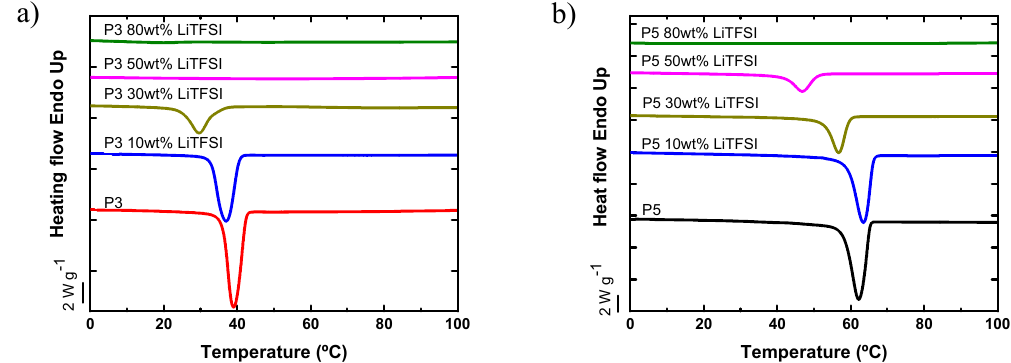
Figure 3. DSC cooling scans of neat P3 and P5 polyethers and their mixtures with different LiTFSI salt concentrations (solid polymer electrolytes: SPEs): ( a ) P3, ( b ) P5.